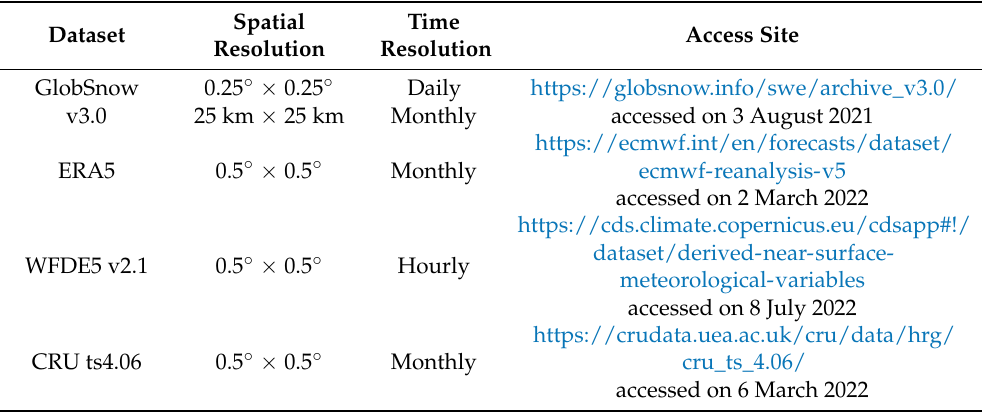
Table 1. List of observational and reanalysis datasets used in the study. The resolution and access site of each dataset are also